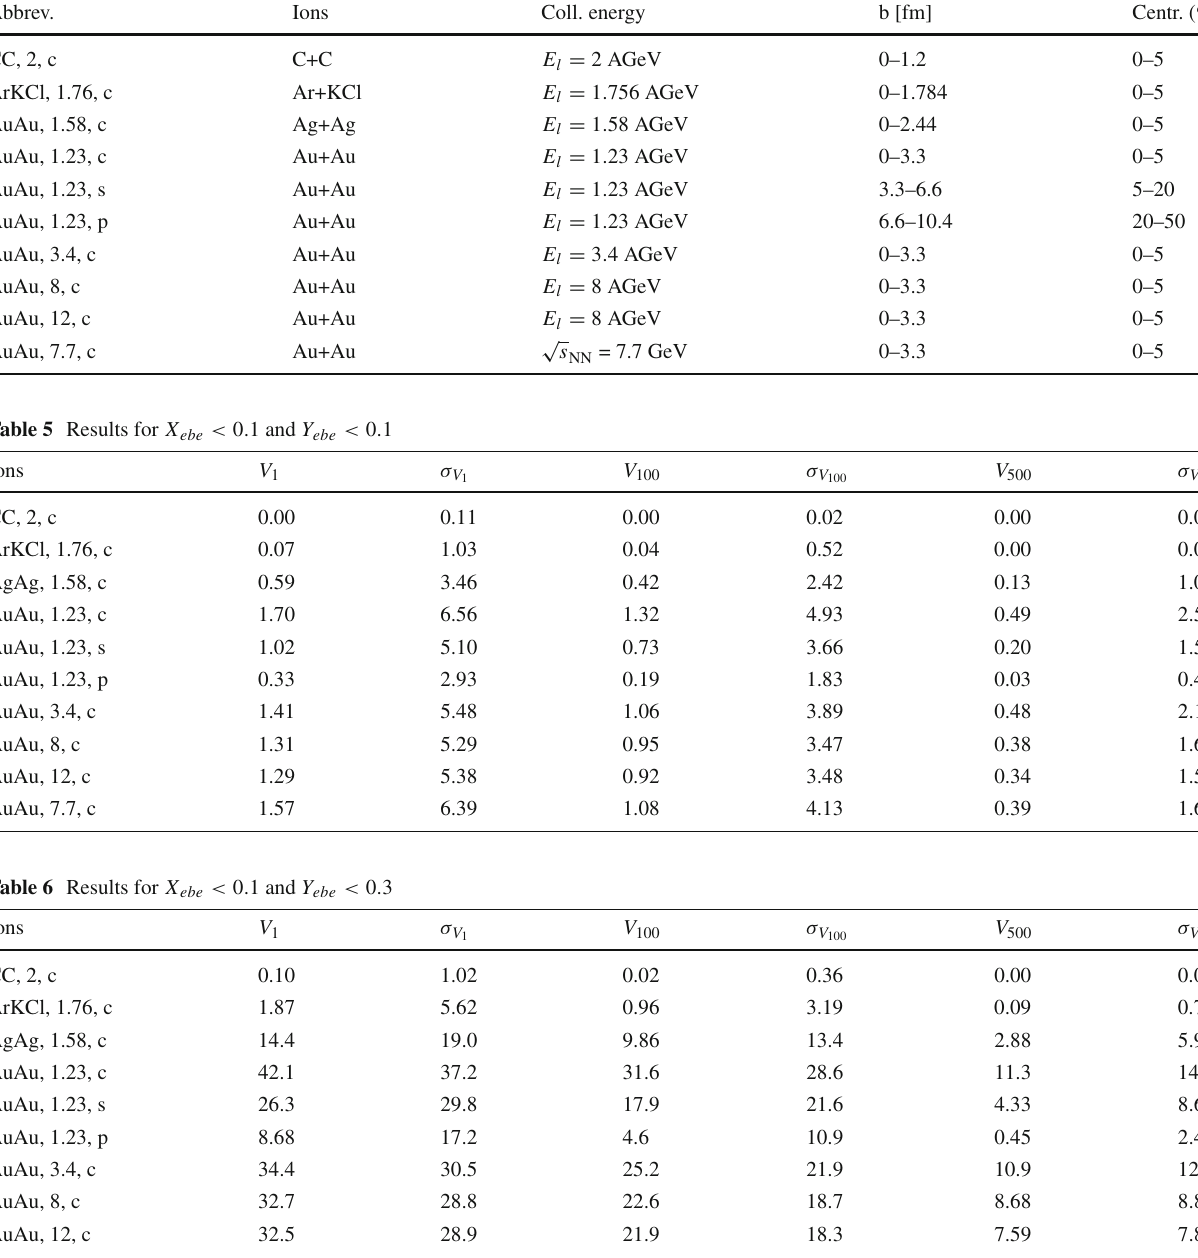
Table 4 List of the systems under examination: abbreviation, ion species, collision energy, impact parameter b range (in fm) and centrality class Abbrev.